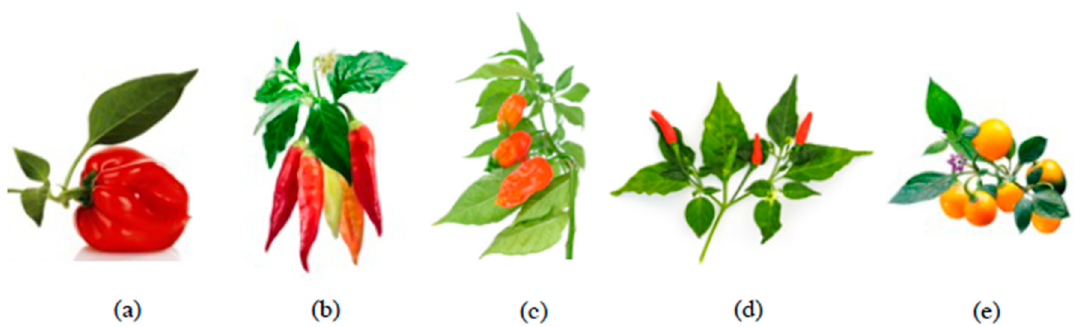
Figure 1. Capsicum fruits: ( a ) C . annuum (sweet bell pepper), ( b ) C . baccatum (aji pepper), ( c ) C . chinense (bhut jolokia pepper), ( d ) C . frutescens (bird’s eye chilli) and ( e ) C . pubescens (rocoto pepper).